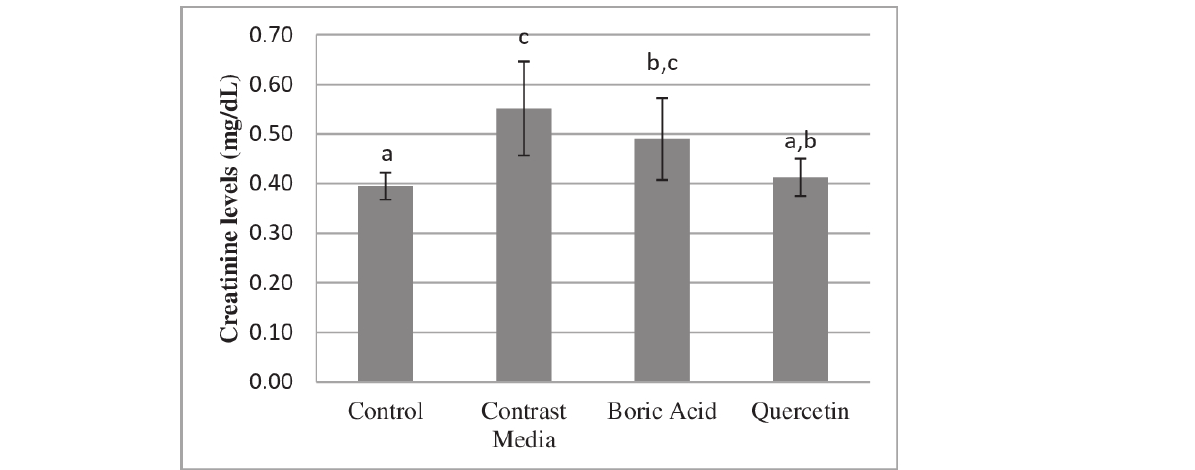
FIGURE 2 - Changes in serum creatinine levels among the groups in our study. Statistically insignificant differences are indicated by identical letters, and statistically significant differences are indicated by different letters. P <0.05 was considered statistically